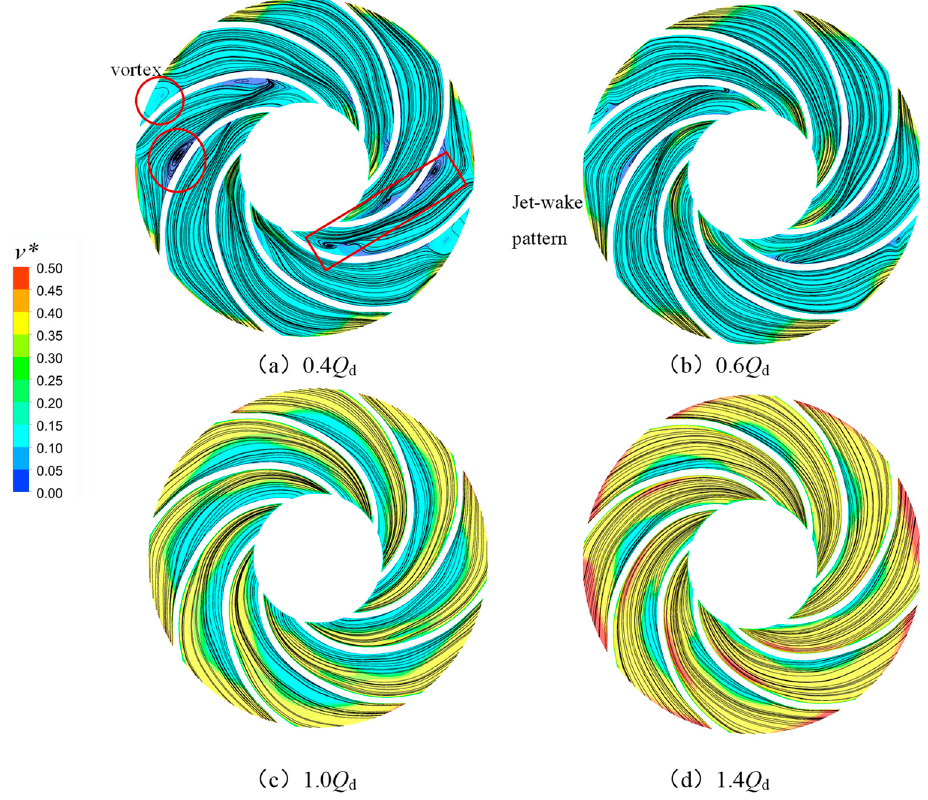
Figure 5. Relative velocity distribution on the mid-span of the first-stage impeller under different flow rates.